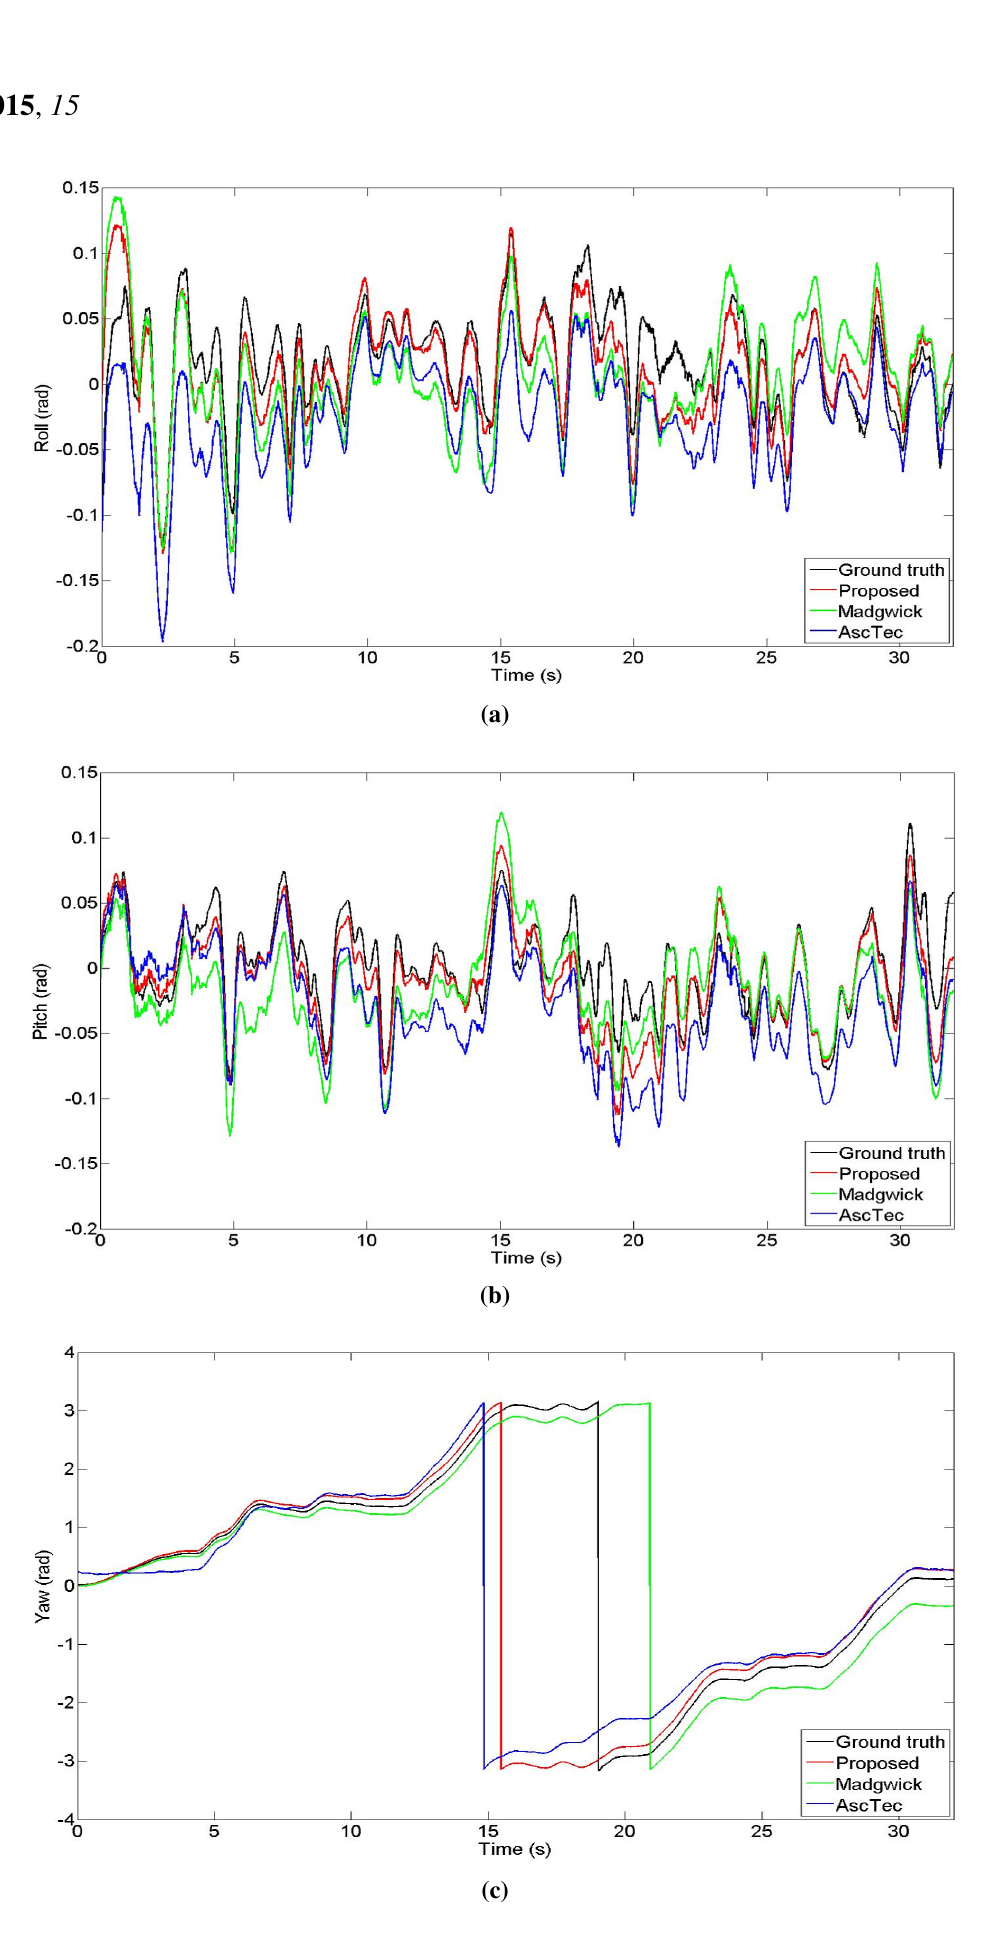
Figure 7. Comparison of the orientation Euler angles output of the three methods during the “1LoopDown” experiment. ( a ) Roll; ( b ) Pitch; ( c )